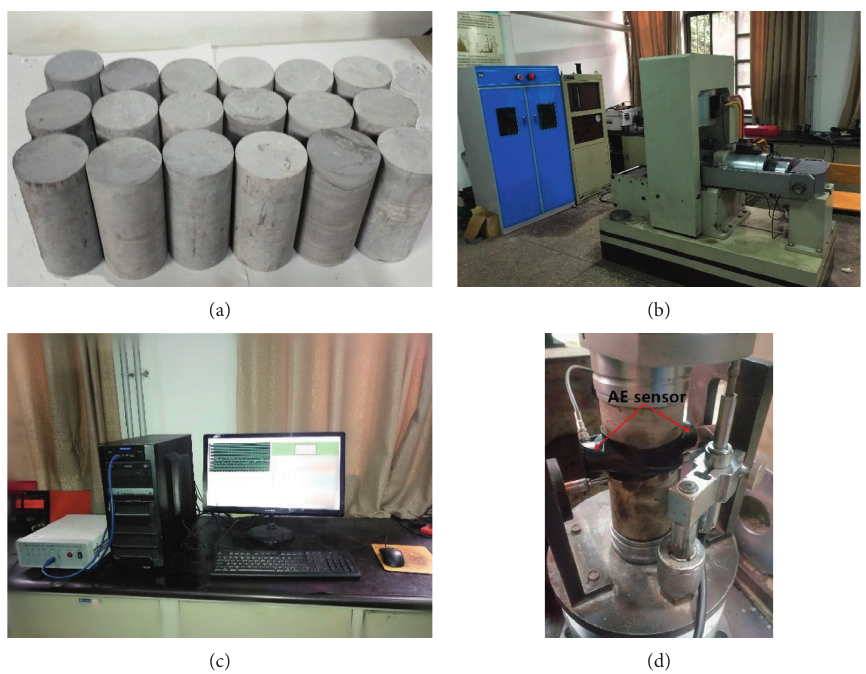
Figure 1: (a) Rock samples. (b) RMT-150B rock mechanics test system. (c) DS5-8B AE. (d) AE sensor arrangement.